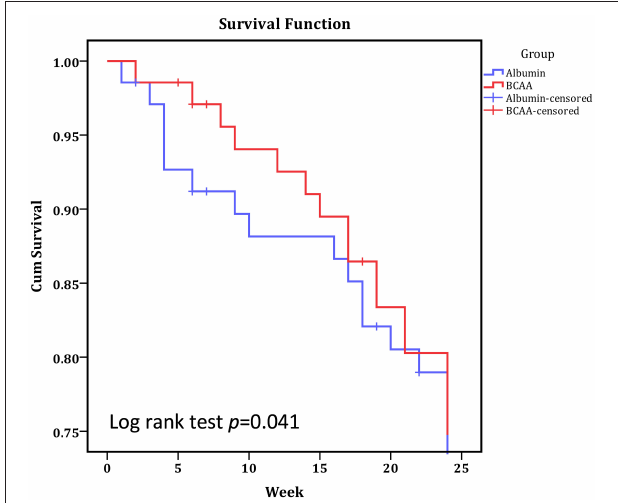
FIGURE 3 | Kaplan Meier analysis of cumulative event-free survival in patients supplemented with BCAA and L-ALB group over 24 weeks. Events were considered death (any reason) and deterioration to exclusion criteria. Statistically significant at p < 0.05.